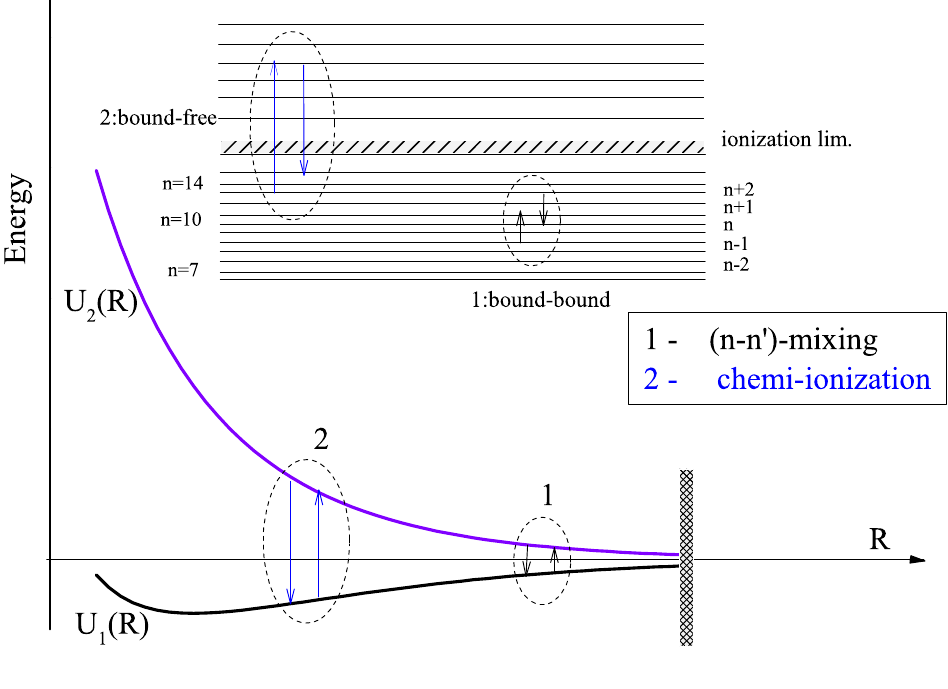
Figure 8. The schematic presentation of the chemi-ionization and (n-n’)-mixing